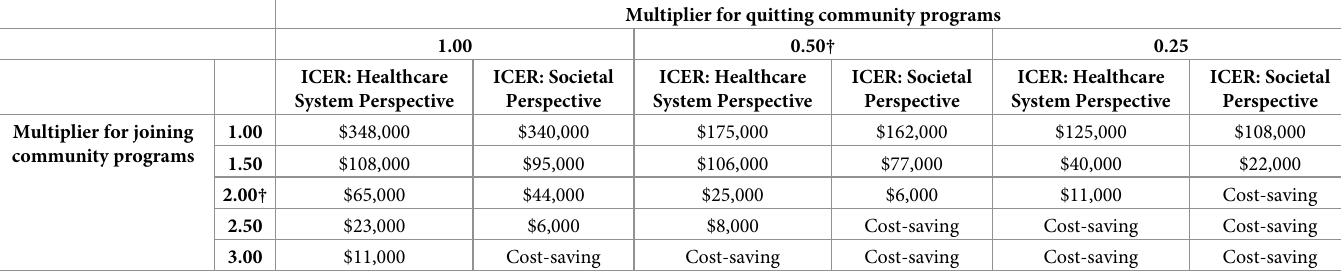
Table 5. Two-way sensitivity analysis on chance of joining and quitting community programs (NSP, SUDT, and HIV and HCV treatment): ICERs �